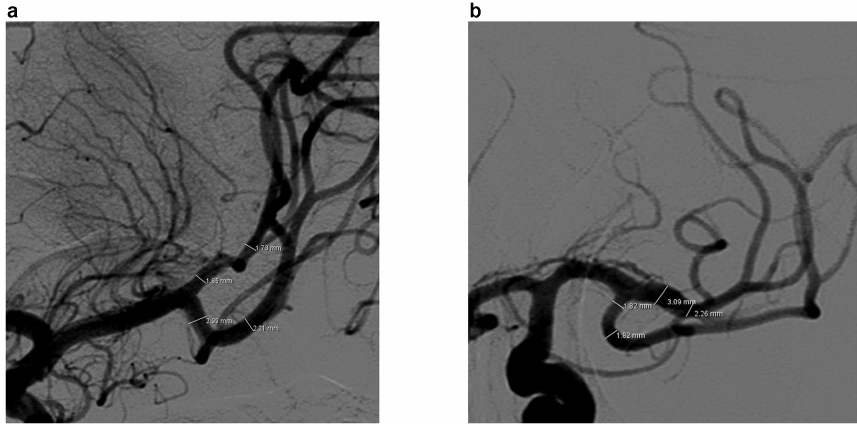
Figure 2. (a) Determination of the dominance of superior branch by measurements. (b) Determination of the dominance of inferior branch by measurements.